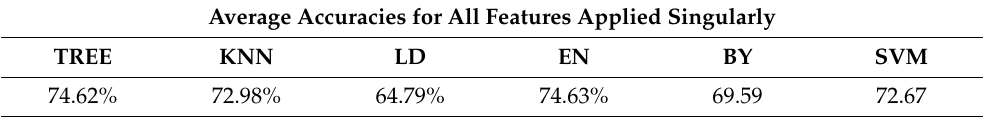
Table 5. Average accuracies calculated for all features applied in